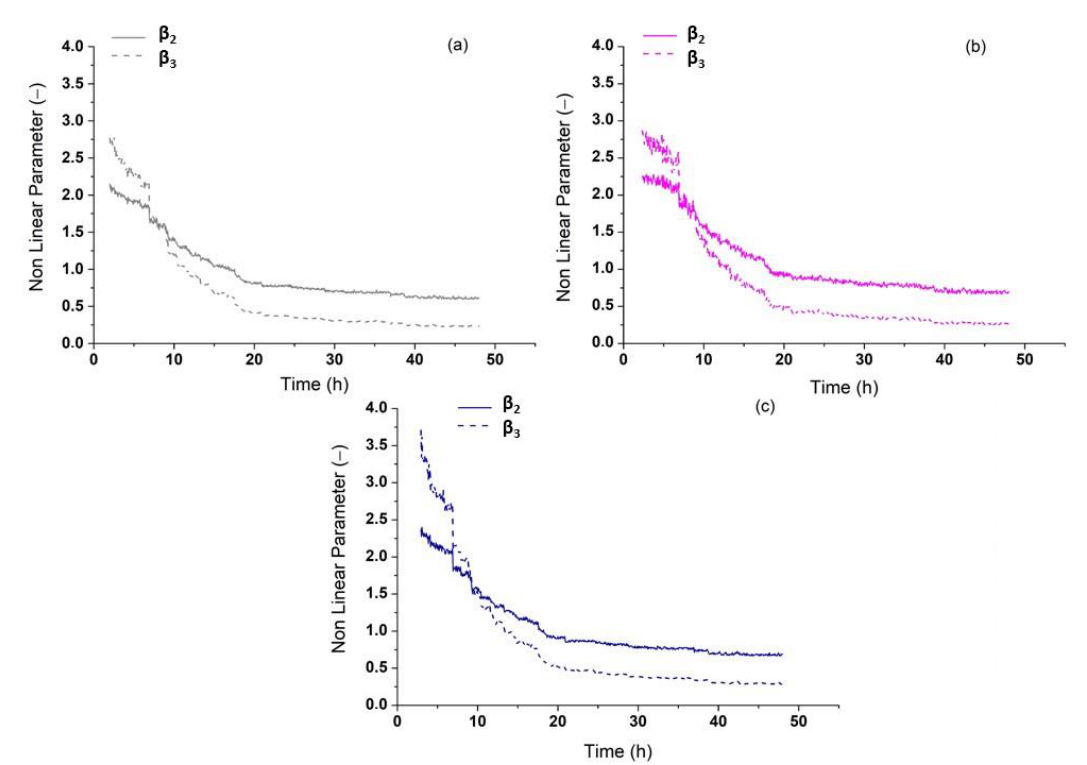
Figure 10. Monitoring the nonlinear behavior of mortar for ( a ) w/c = 0.4, ( b ) w/c = 0.5 and ( c ) w/c = 0.6.